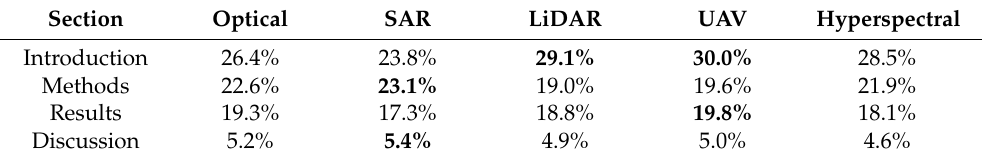
Figure 11. Average numbers of words ( left ) and average numbers of equations ( right ) for selected sensors discussed in articles published in Remote Sensing . Table 8. Average fraction of words per article section of articles using the main remote sensing